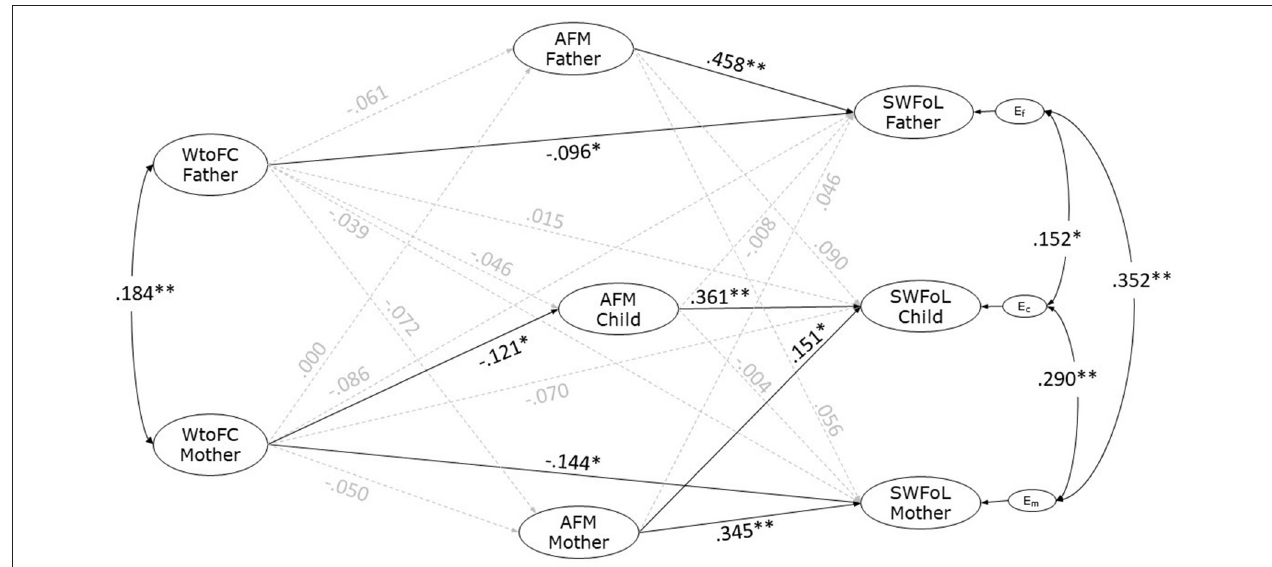
FIGURE 2 | Actor-partner interdependence model of the effect of parent’s Work-to-Family Conflict (WtoFC) on the three family members’ Perception of the Atmosphere of Family Meals (AFM) and Satisfaction with Food-related Life (SWFoL) in dual-earner parents with adolescent children. E f , E c and E m , residual errors on SWFoL for the fathers, mothers, and their adolescent children, respectively. * p < 0.05; ** p < 0.01. The control for the effects both members of the couple’s age, type of employment and their number of working hours as well as the family SES, the number of children and the number of supper meals in which all the family members ate together during a week on the dependent variables of the three family members (AFM and SWFoL) were not shown in the path diagram.